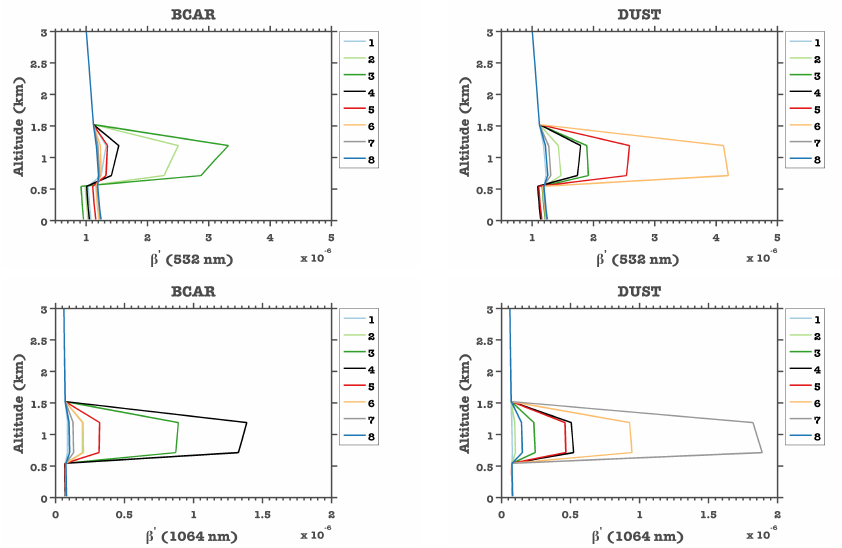
Fig. 4. Profiles of attenuated backscatter ( β 0 ) for BCAR (left) and DUST (right), per size section (bin) as a function of altitude for λ = 532, 1064nm.